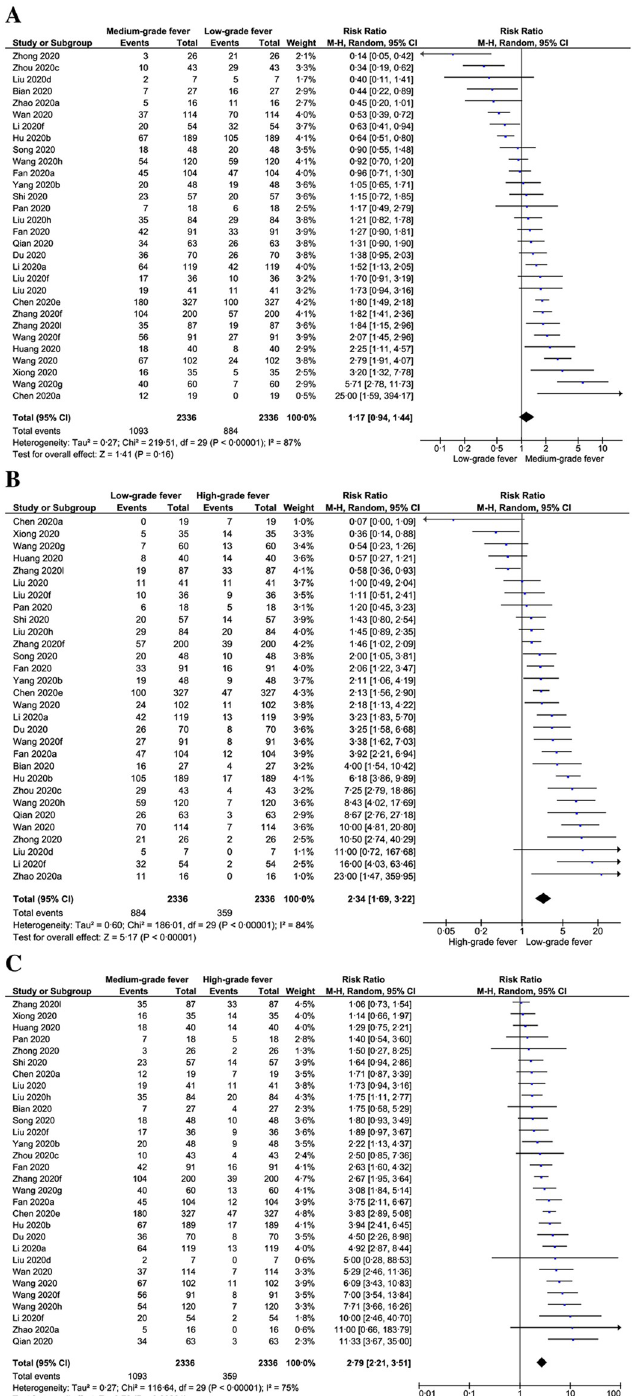
Fig 5. Risks of (A) low-grade fever (37 � 3–38 � 0˚C) vs medium-grade fever (38 � 1–39 � 0˚C), (B) high-grade fever ( > 39 � 0˚C) vs low-grade fever (37 � 3–38 � 0˚C), and (C) high-grade fever ( > 39 � 0˚C) vs medium-grade fever (38 � 1– 39 � 0˚C) in adult COVID-19